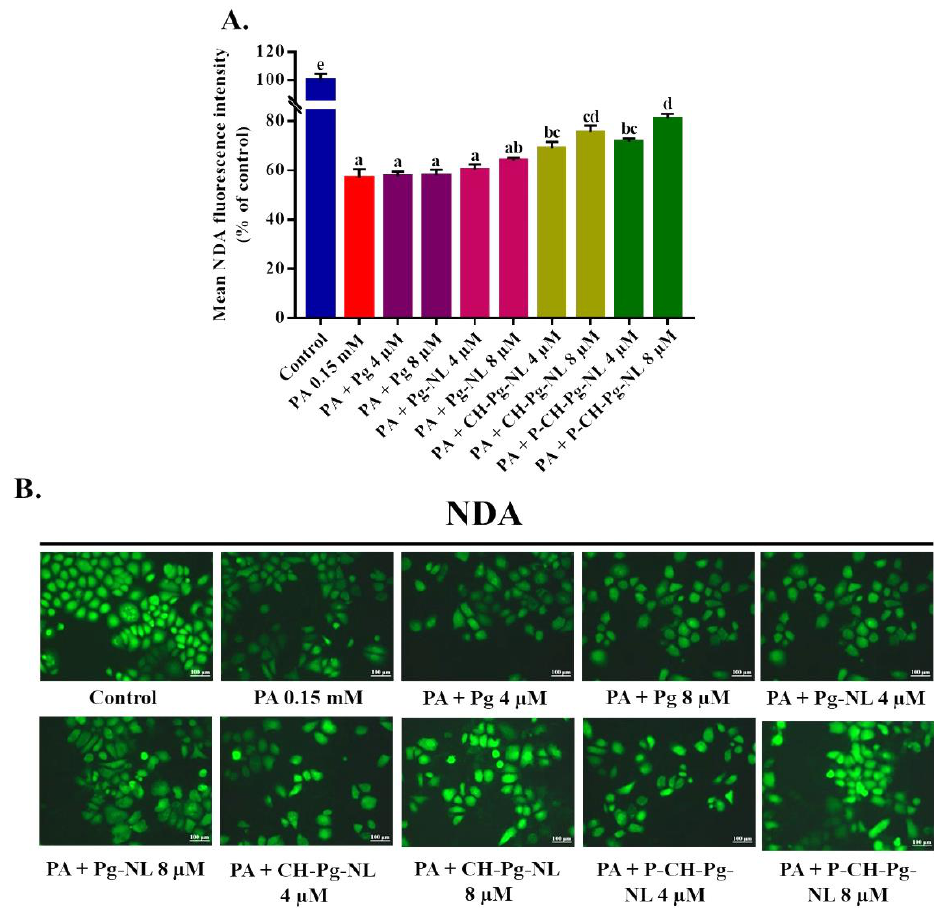
Figure 7. Effects of free-Pg and Pg-loaded liposomal systems on PA-induced cellular GSH depletion in L02 cells. ( A ) Quantitative determination of GSH as “% of mean NDA fluorescence intensity compared to control”. ( B ) Qualitative determination of GSH by “photographs of NDA fluorescence intensity of different samples”. Individual alphabet represents the significant difference ( p < 0.05) of all treatment groups. Here, PA = palmitic acid; Pg-NL = Pelargonidin- 3-O -glucoside-loaded uncoated nanoliposomes; CH-Pg-NL = Pg-NL coated by chitosan; P-CH-Pg-NL = CH-Pg-NL coated by pectin.